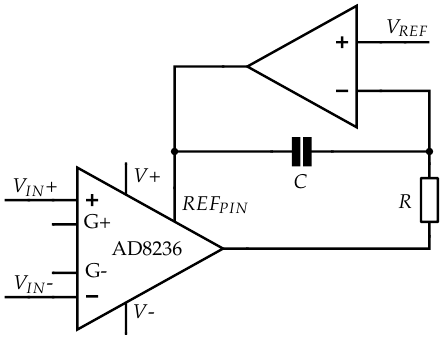
Figure 5. INA with DC rejection reference design with negative feedback of the low-frequency signals to the REF PIN of the AD8236 instrumentation amplifier. This circuit leads to a highpass with cutoff frequency f C (23.4 Hz) defined by R (68 k Ω ) and C (100 nF) (see Equation (2))